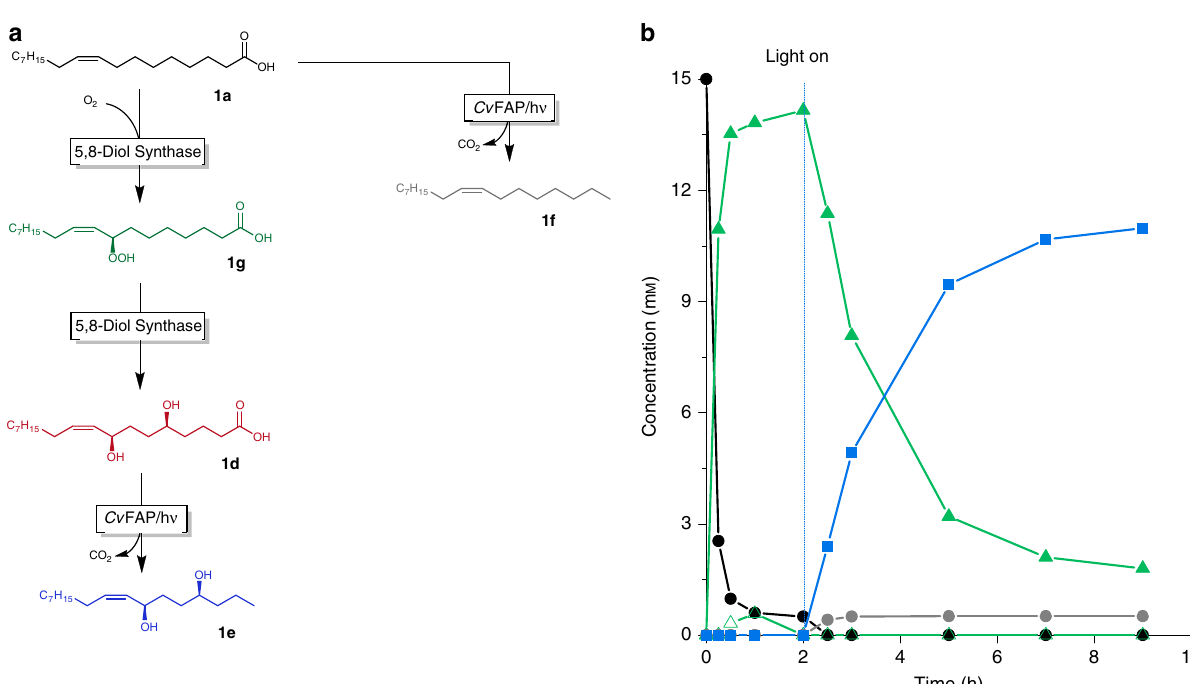
Fig. 7 Photoenzymatic cascade. a Reaction scheme of the photoenzymatic cascade transforming oleic acid into Photoenzymatic diol synthesis- decarboxylation of oleic acid. b Typical time course [oleic acid] = 15 mM, [ An DS cells] = 7 g L − 1 , [ Cv FAP cells] = 7 g L − 1 , HEPES buffer pH 7.5 (50 mM, with 10% (v/v) DMSO), illumination with blue light ( λ = 450 nm; intensity = 13.7 mE L − 1 s − 1 ): oleic acid (black circles), 8-hydroperoxy-9(Z)-octadecenoic acid ( 1g , green empty triangles), 5,8-dihydroxy-9( Z )-octadecenoic acid ( 1d , green triangles), ( 4S , 7R , Z )-heptadec-8-ene-4,7-diol ( 1e , blue squares), ( Z )- heptadec-8-ene ( 1f , grey circles). For the reaction, fi rst the An DS-catalysed diol synthetic reaction was performed for 2 h followed by addition of Cv FAP and illumination for another 7 h. The absolute con fi guration is based on the enantioselectivity of the synthase as previously established by Oh and coworkers 28,48